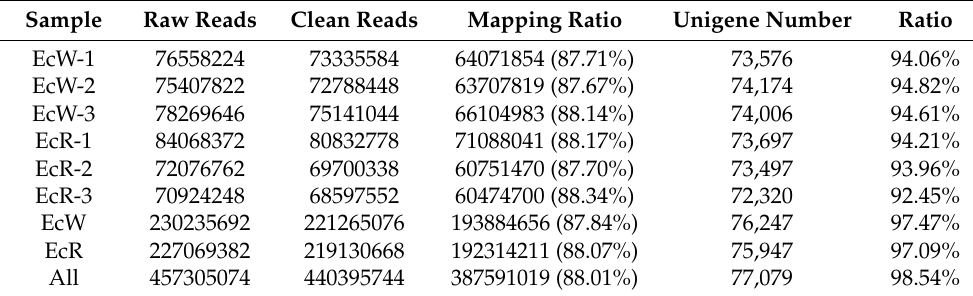
Table 2. Summary of sequencing and assembly of the